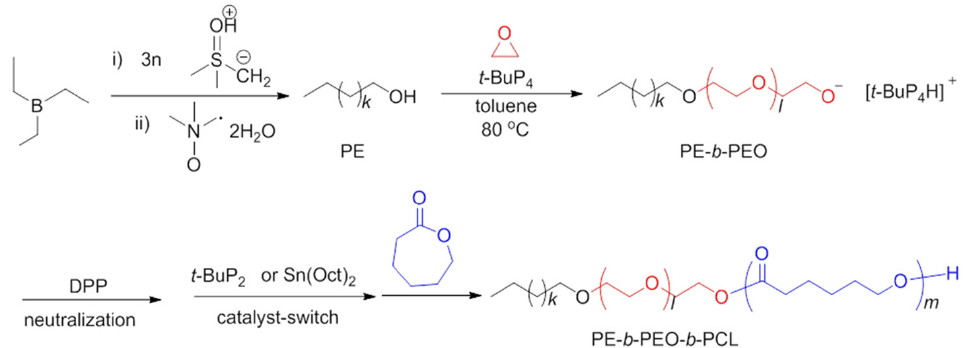
Scheme 1. Synthesis of tricrystalline terpolymer PE- b -PEO- b -PCL by a combination of polyhomolo- gation and two catalyst-switch strategies [102].